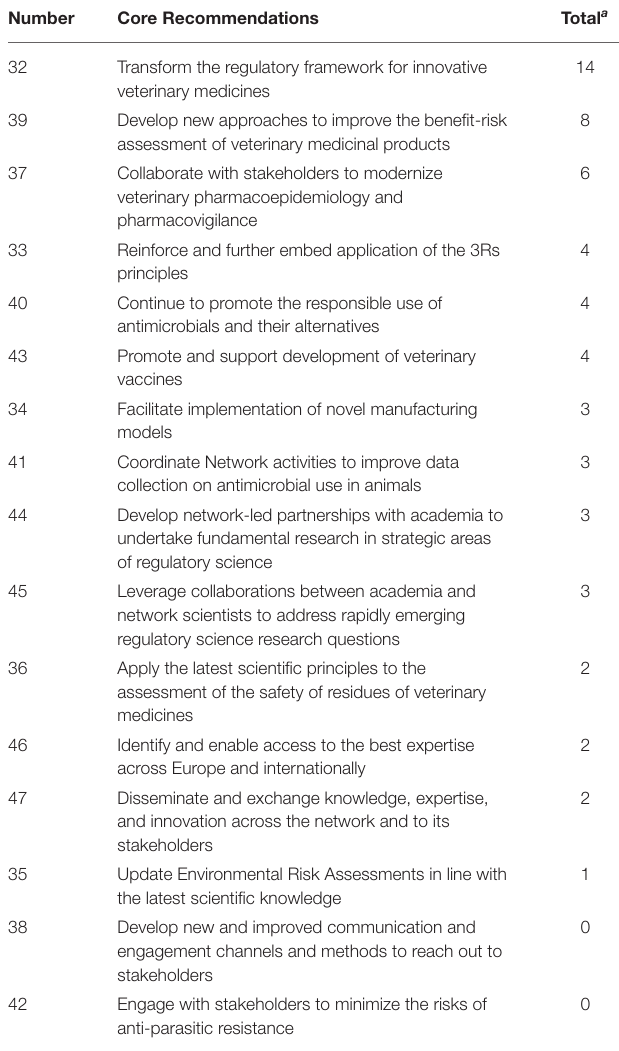
TABLE 4 | Aggregate ranking of Core Recommendations (question 5, veterinary